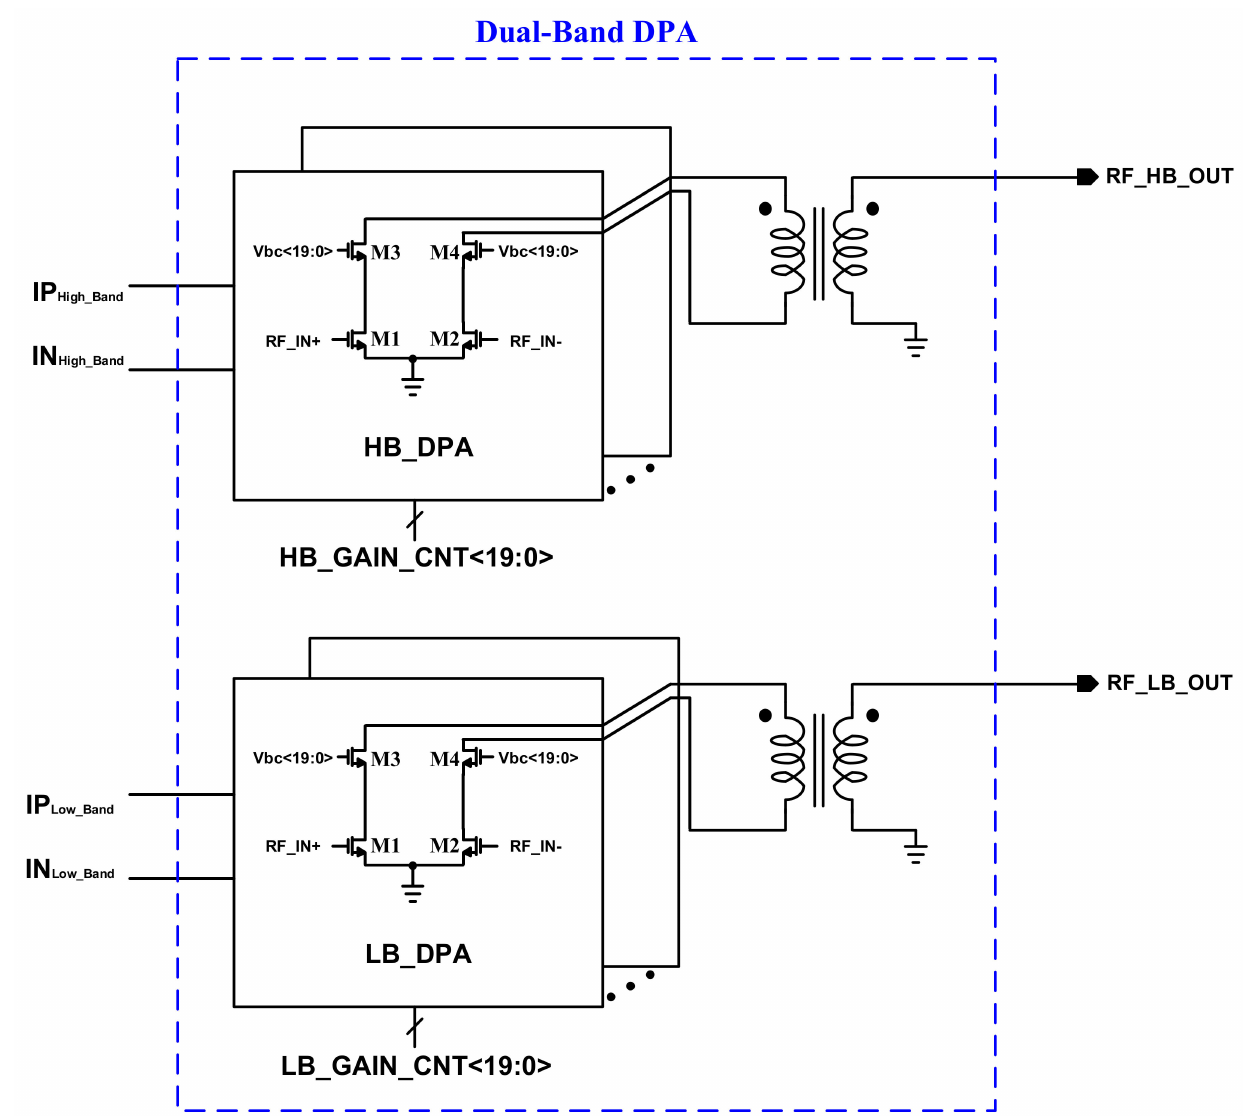
Figure 1. The top block-diagram of the proposed dual-band structure of the DPA covering whole the sub-bands of the NB-IoT